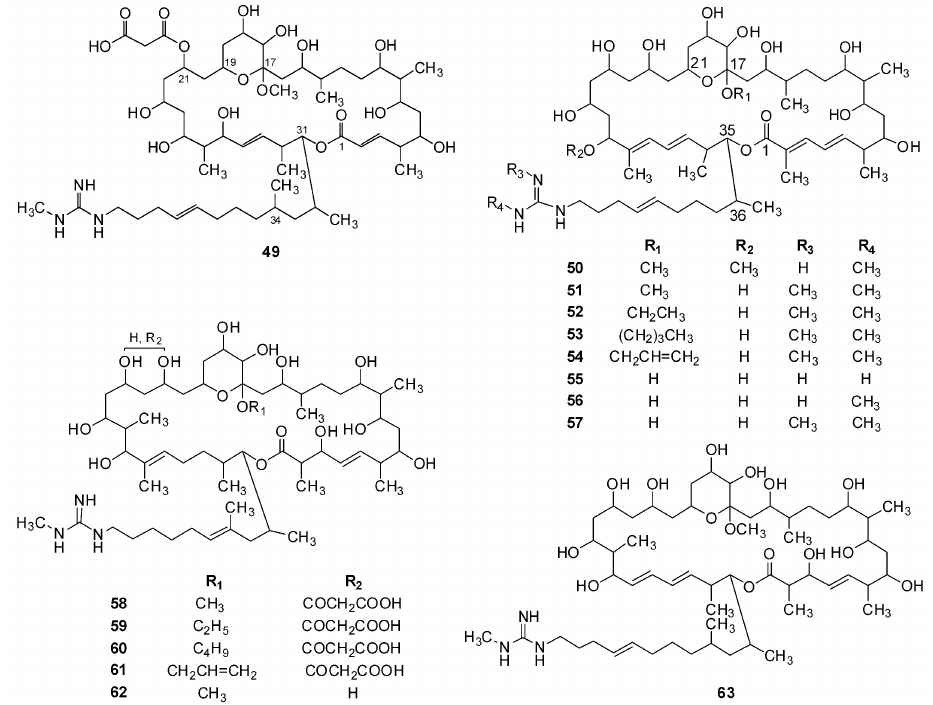
Figure 5. Structural derivatives ( 49 – 63 ) of some guanidine-containing polyhydroxyl macrolides. Compounds